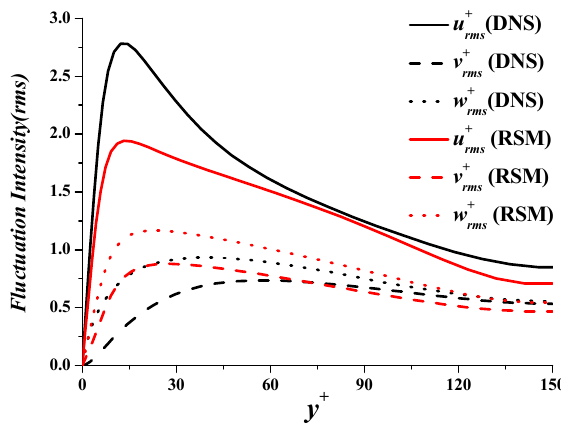
Figure 3. Fluctuation intensities.